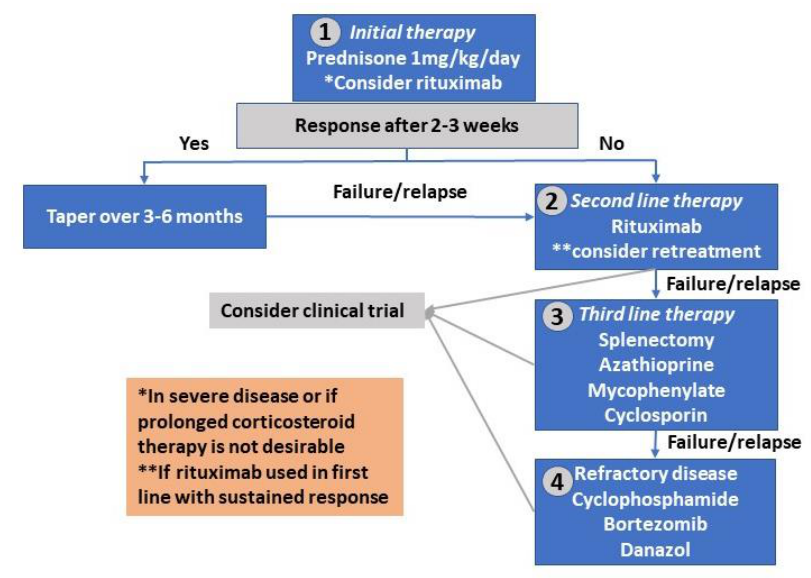
Figure 1. Treatment algorithm for warm autoimmune hemolytic anemia. “*” = in severe disease or if prolonged corticosteroid therapy is not desirable; “**” = if rituximab is used in the first line with sustained response.